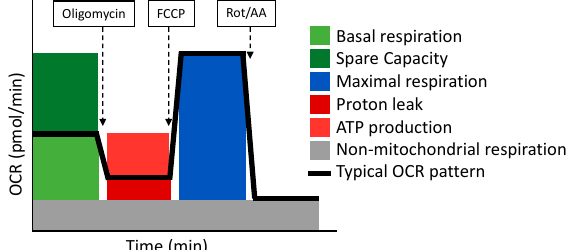
Figure 3. The Cell Mito Stress Test respirometry assay and its related parameters. Adapted from Seahorse (Agilent). The Cell Mito Stress Test as a Dynamic Approach to Assess the Redox State Recent findings have proven a correlation between altered mitochondrial function